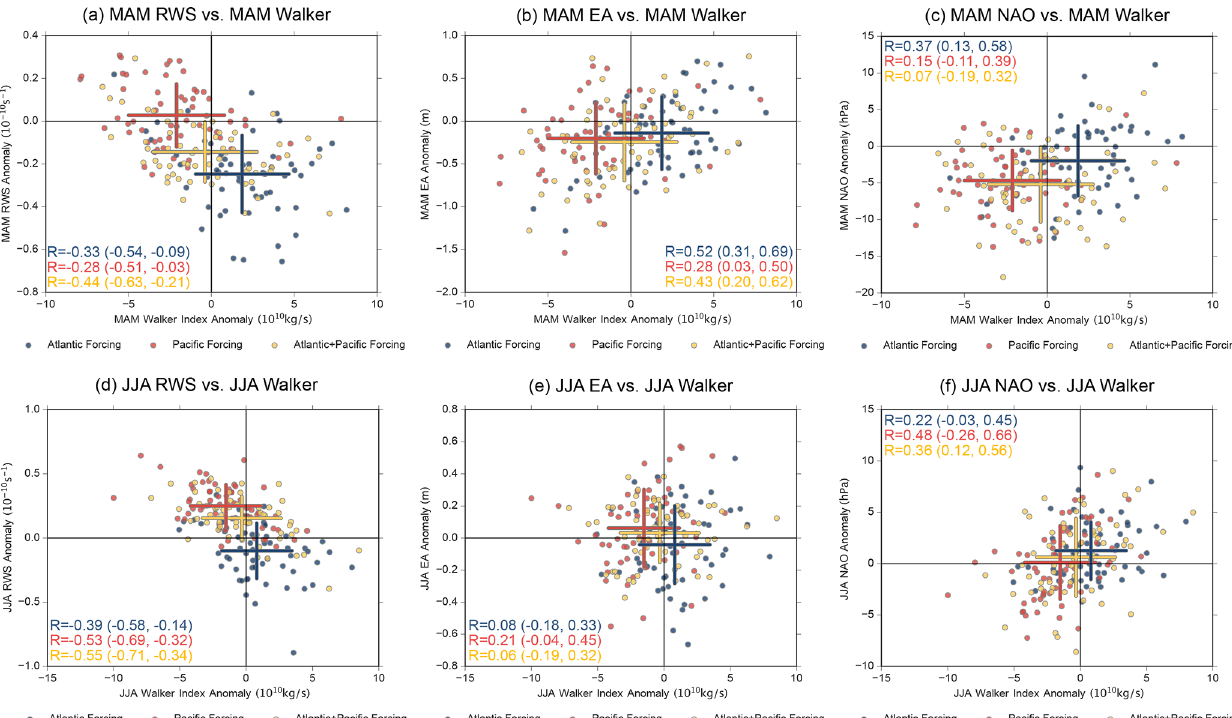
Figure 8. Scatter plot for model data showing the key relationships between the Walker index, RWS index, East Atlantic index, and NAO index. Forcing areas are indicated in the legend, including red, yellow, and blue points for P , AP, and A , respectively. The correlation coefficient ( R ) is represented in the corner of each panel, with colors representing the forcing area. The central points of the crosses represent the means of all values in each category of the variables indicated on both axes. The extent of the crosses indicate 1 standard deviation in the x and y